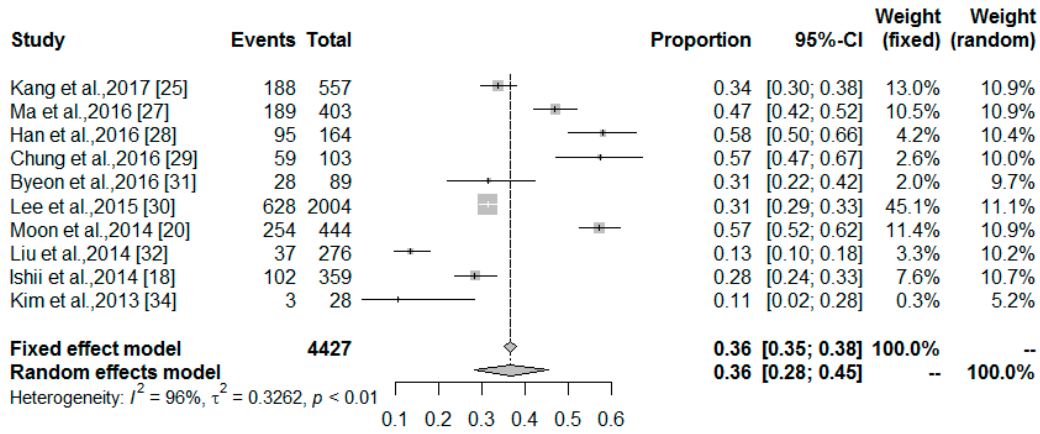
Figure 2. Forest plot of the meta-analysis for the overall MetS prevalence in middle-aged and older non-obese adults with sarcopenia.